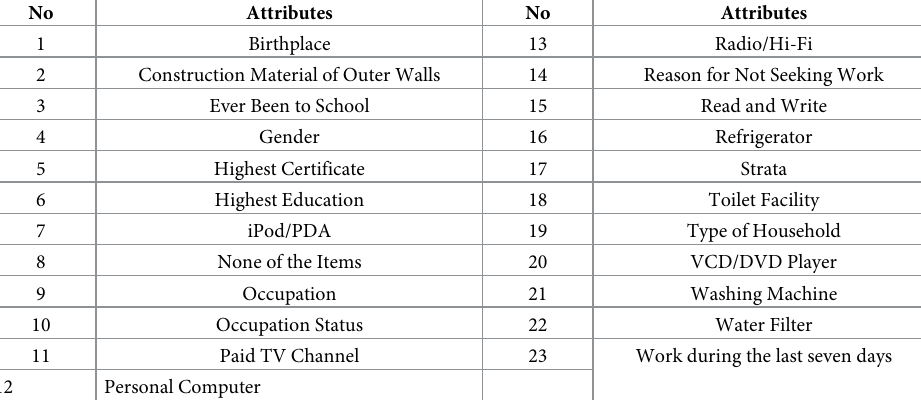
Table 5. A set of attributes after unsupervised feature